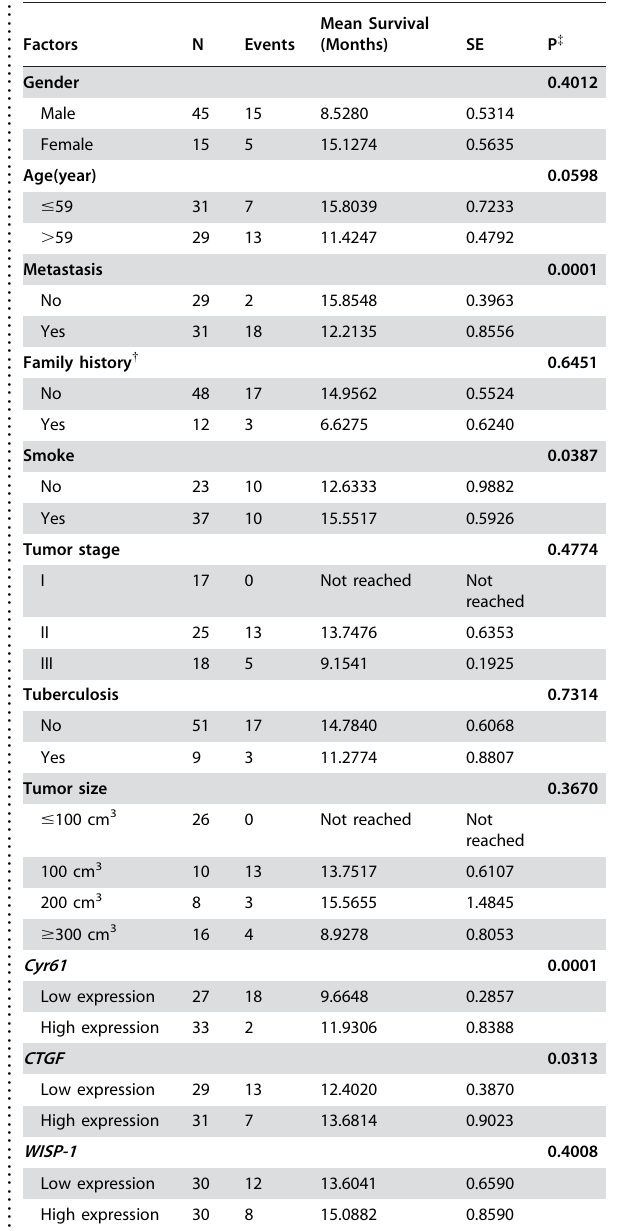
Table 4. Univariate survival analysis of expression of Cyr61, CTGF and WISP-1 mRNA in lung cancer and the clinical and